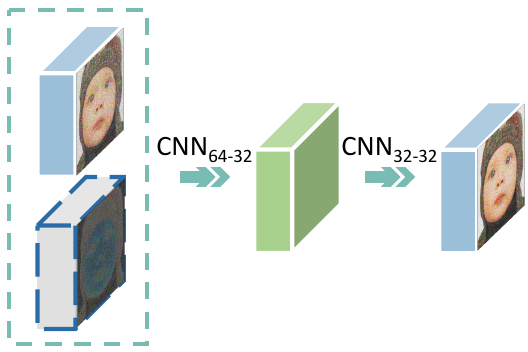
Figure 8. The fusion of errors in ES. At first, the two input feature maps IF i − 1 and EF i , which are represented by blue and gray cubes, respectively, are concatenated. Then, the features are encoded into a hidden feature with 32 channels (shown as the green cube) and decoded to achieve the final result IF i . In this way, the full fusion between errors and intermediate features can be achieved. The encoder and decoder are realized by two 3 × 3 convolution and ReLU layers of CNN 64 − 32 and CNN 32 − 32 , respectively.